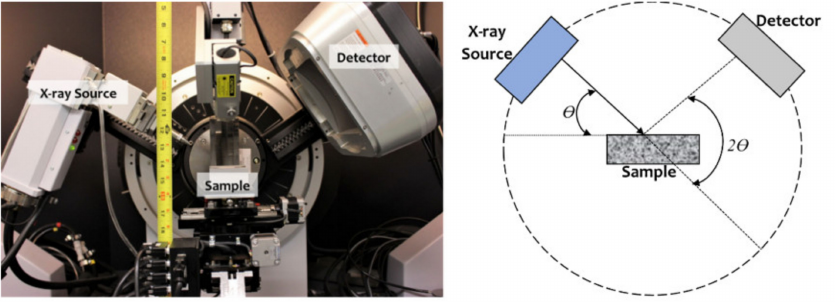
Figure 4. The Bruker D8 Discovery X-ray Diffractometer and a schematic view of the detector position—MIAM.